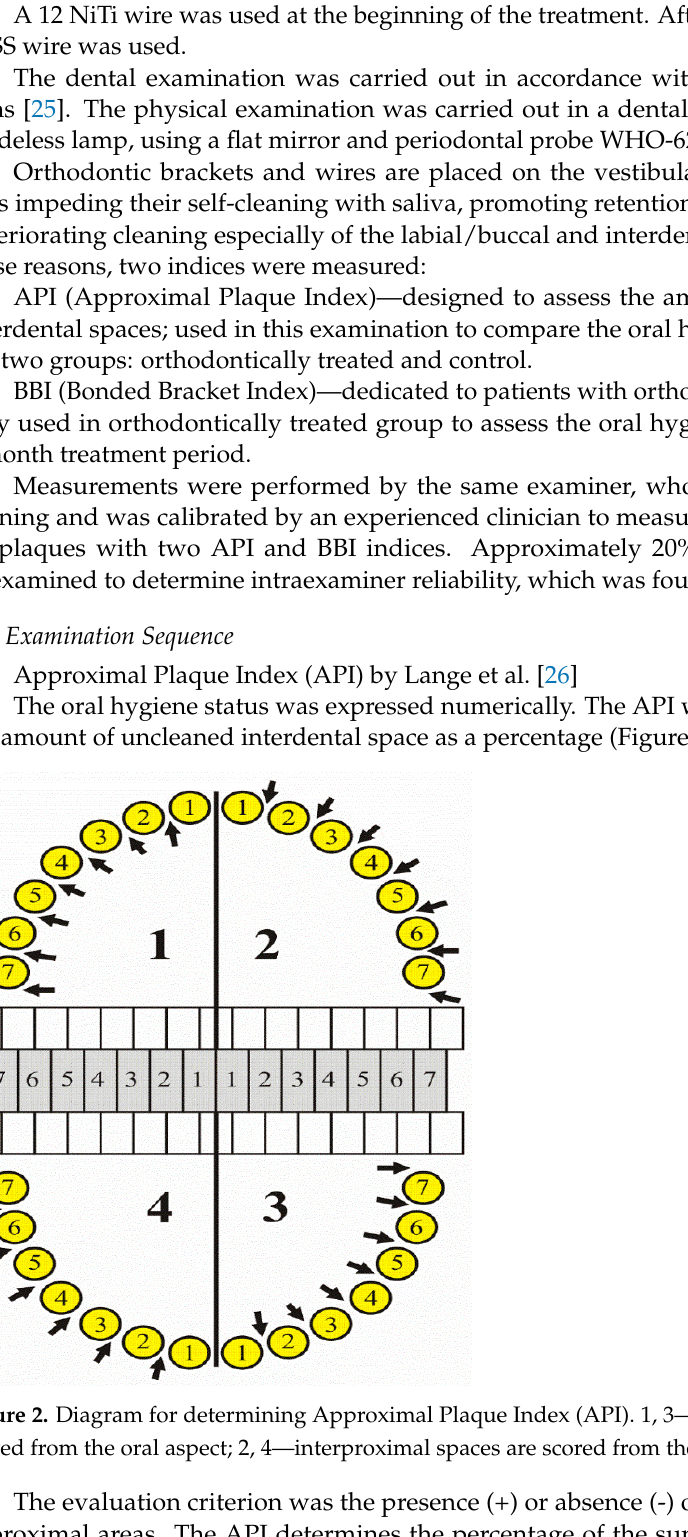
surfaces in relation to the sum of all examined